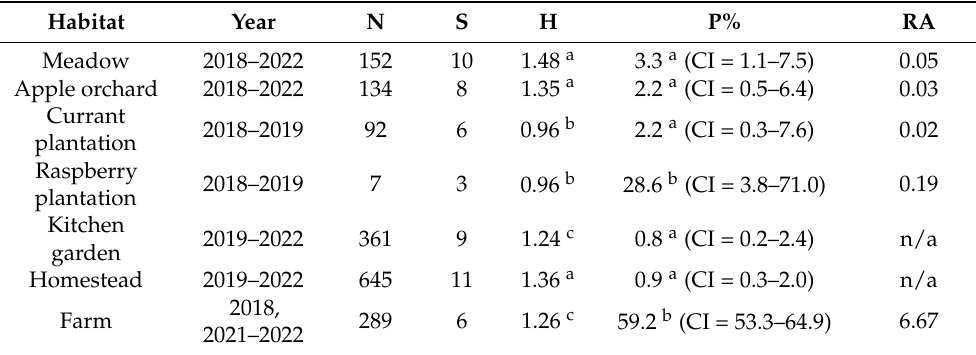
Table 2. Characteristics of small mammal communities in relation to gradient of habitats, from natural to farms. N—number of trapped small mammal individuals; S—number of trapped species; H—diversity (Shannon’s index); P%—proportion of M. musculus (95% CI); RA– relative abundance of M. musculus (individuals per 100 trap days). Superscript letters denote differences of the values in columns, significant at p <